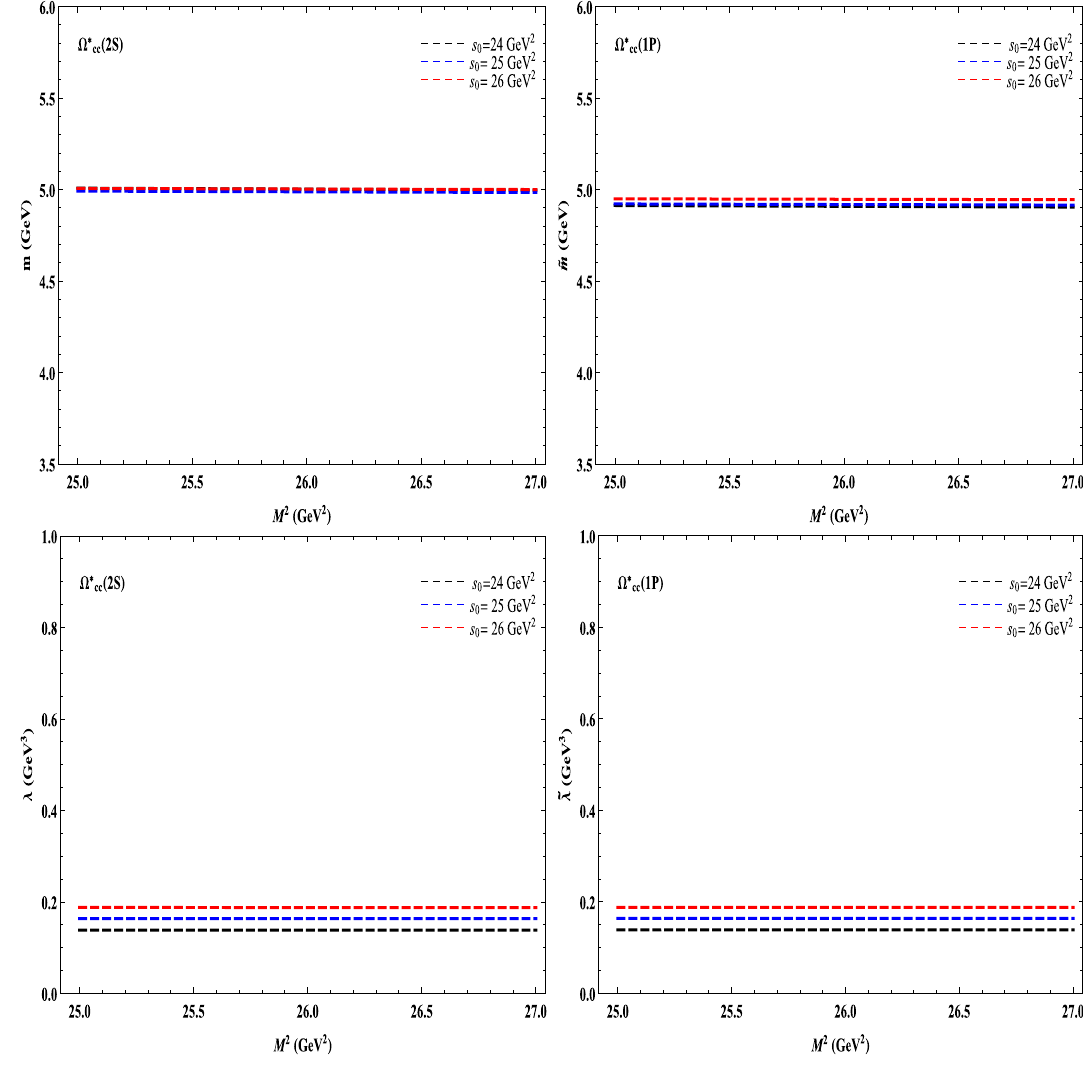
Fig. 5 The dependency of the excited states 2 S , 1 P masses, and pole residues of the doubly-heavy of spin-(3/2) (cid:3) ∗ cc baryon on the Borel mass M 2 at different values of the continuum threshold s